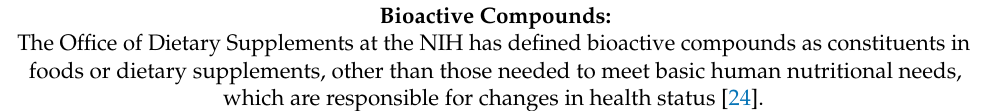
Table 4. Terms linked with functional